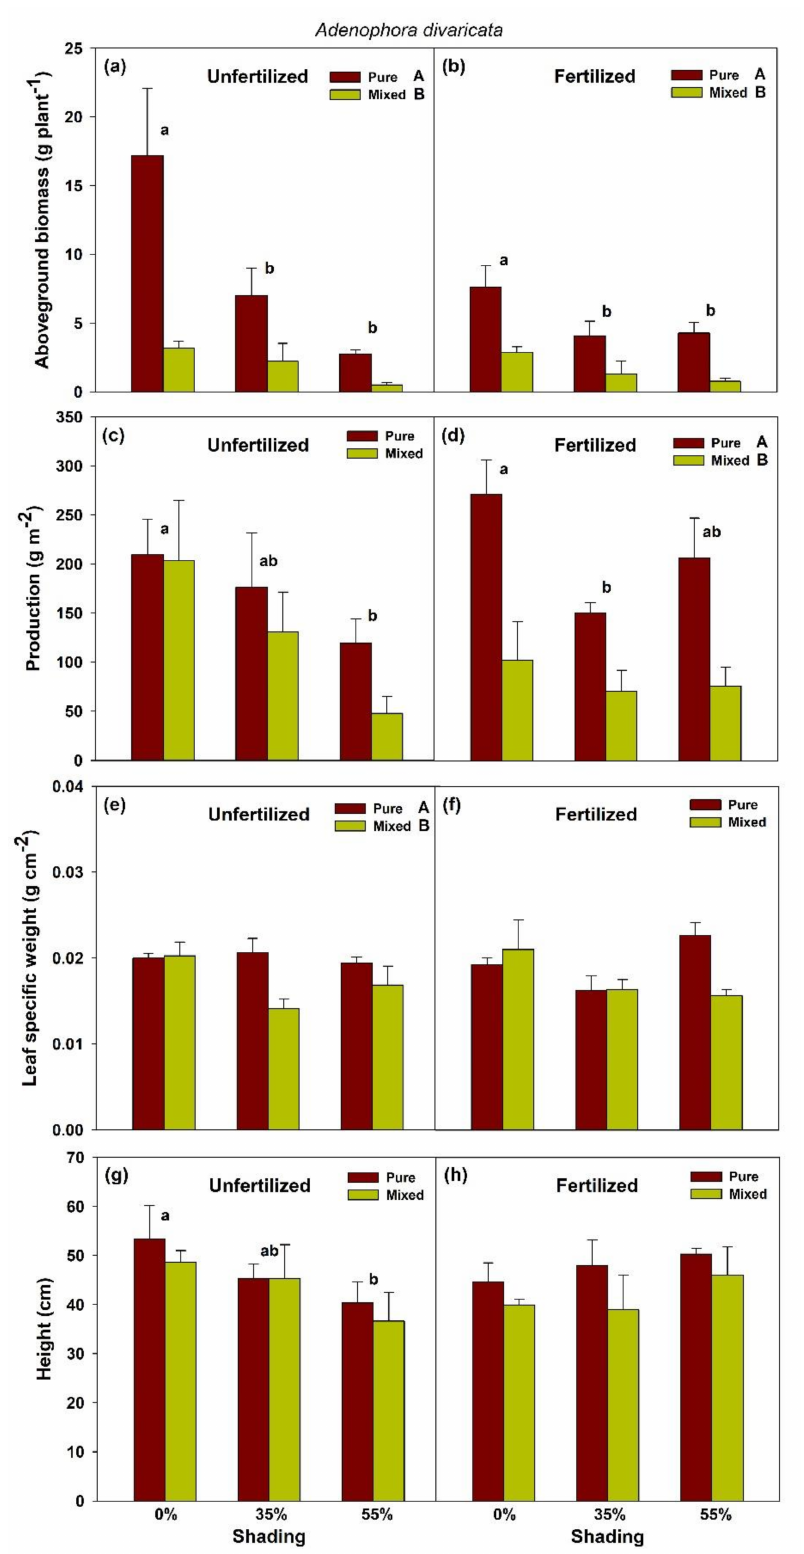
Figure 2. Aboveground biomass ( a , b ), shoot production ( c , d ), leaf-specific weight ( e , f ), and height growth ( g , h ) of pure Adenophora divaricata and mixed Heracleum moellendorffii + Adenophora divaricata in different light and fertilization treatments. Different lowercase and uppercase letters indicate statistical significance across shade treatments and between planting methods, respectively. Vertical bars show standard errors ( n =